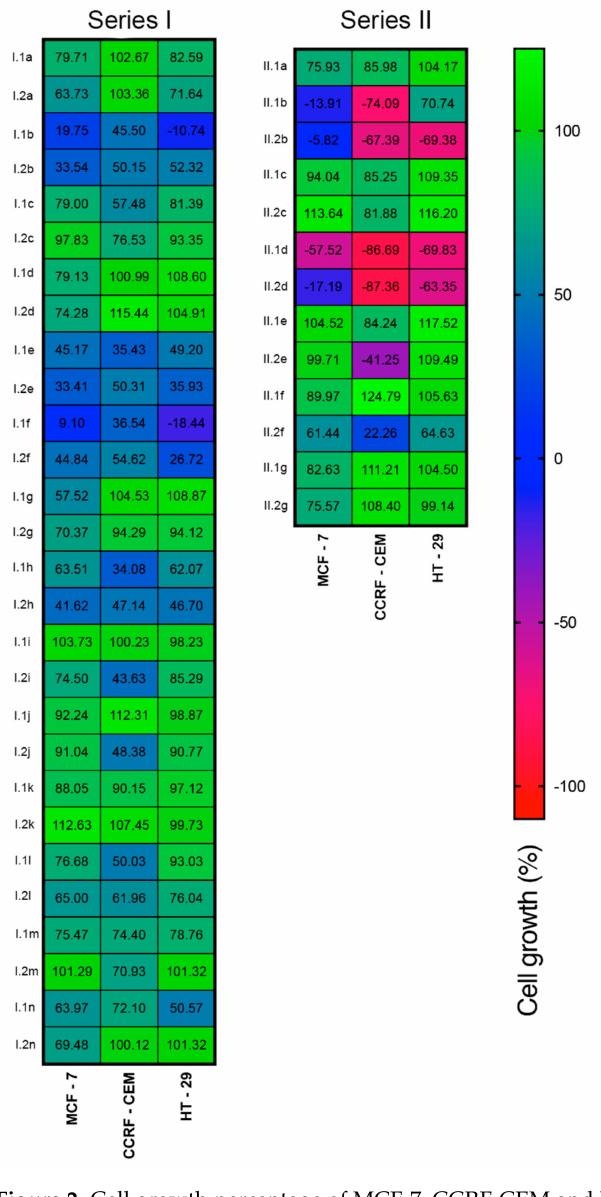
Figure 2. Cell growth percentage of MCF-7, CCRF-CEM and HT-29 cells treated with series I and II compounds at 10 µ M after 48